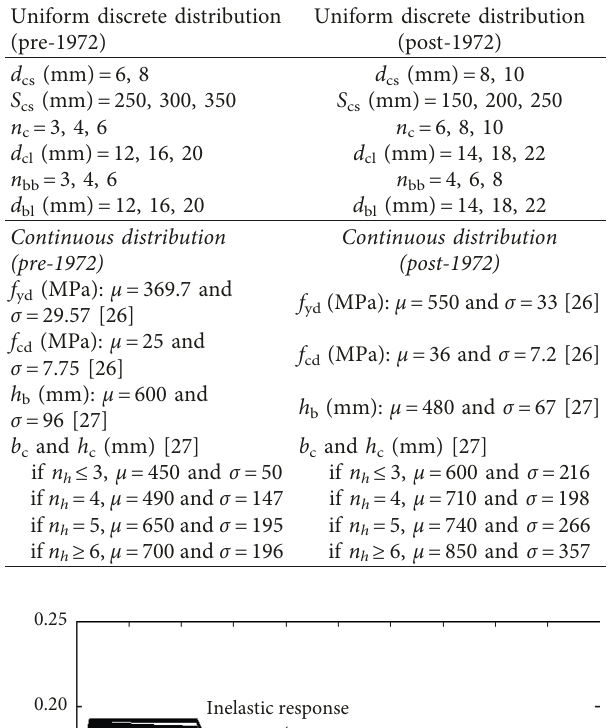
Table 3: Considered random variables in structural analysis.